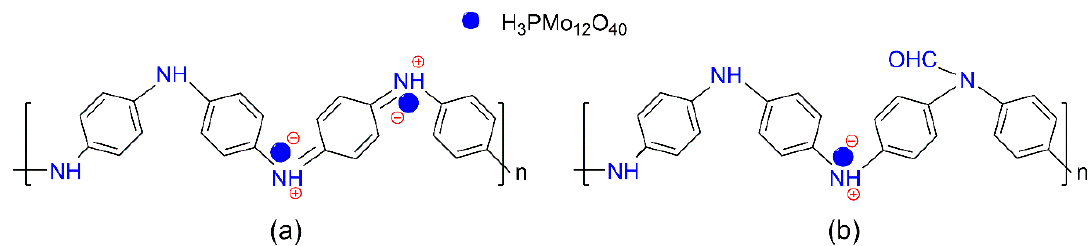
5-hydroxymethylfurfural (HMF) to DFF a